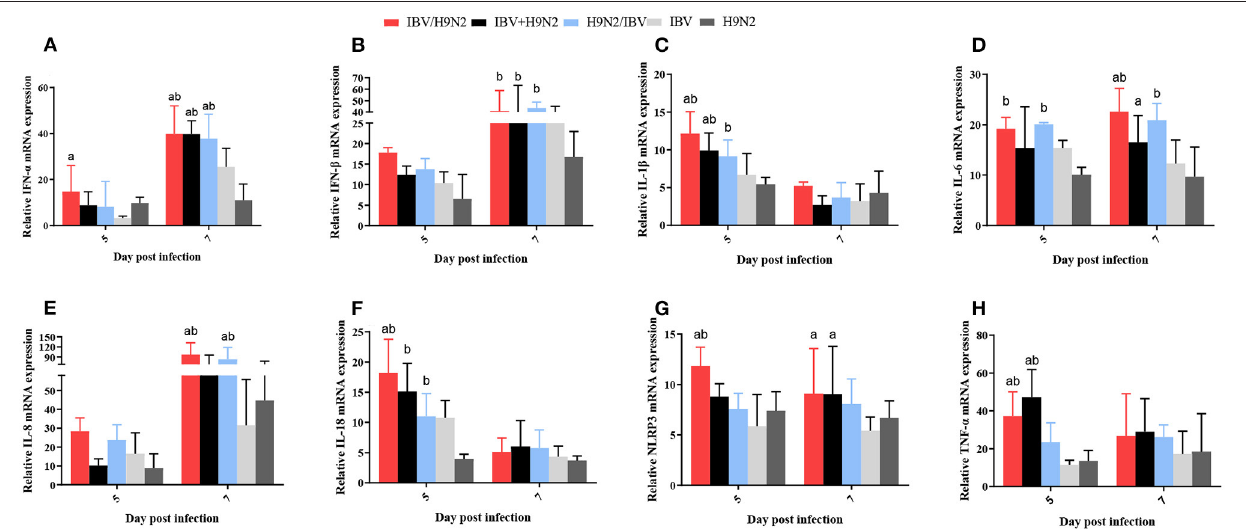
FIGURE 9 | Effect of co-infection with IBV and H9N2 virus on inflammatory cytokines in the chicken trachea. (A) IFN- α , (B) IFN- β , (C) IL-1 β , (D) IL-6, (E) IL-8, (F) IL-18, (G) NLRP3, and (H) TNF- α . Data are presented as means ± SD. “a” indicates a significant difference ( P < 0.05) between the three co-infection groups and the IBV group. “b” indicates a significant difference ( P < 0.05) between the three co-infection groups and the H9N2 group. “ab” indicates a significant difference ( P < 0.05) between the three co-infection groups and the H9N2 group. IBV, infectious bronchitis virus; IFN, interferon; IL, interleukin; NLRP3, NLR family pyrin domain containing 3; TNF- α , tumor necrosis factor- α ; SD, standard deviation.